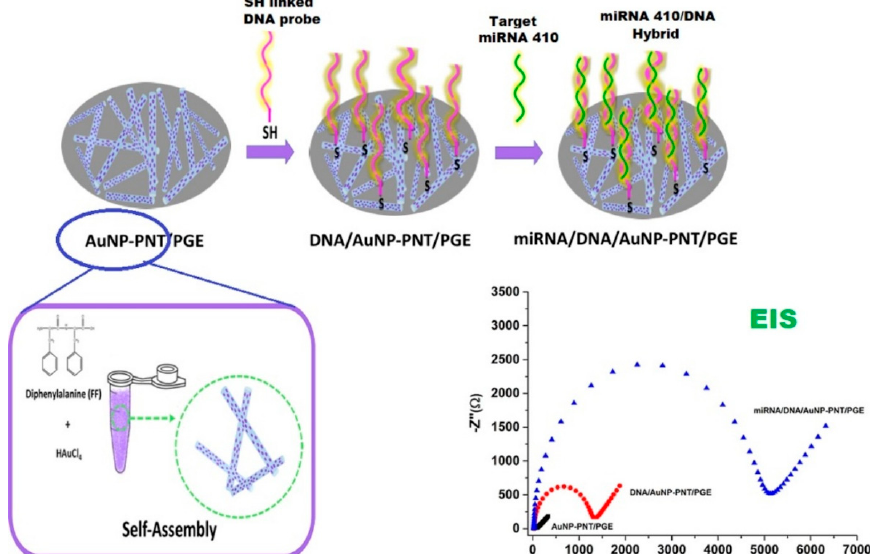
Figure 7. Schematic diagram of one-pot synthesized gold nanoparticle-peptide nanotube modified sensor for impedimetric recognition of miRNA, where HAuCl 4 , AuNP-PNT, and PGE represent gold(III) chloride, gold nanoparticles/peptide nanotubes, and pencil graphite electrode, respectively. Figure source: [50]. Reproduction of the figure was granted from the publisher; the reference number is 210801-024789.